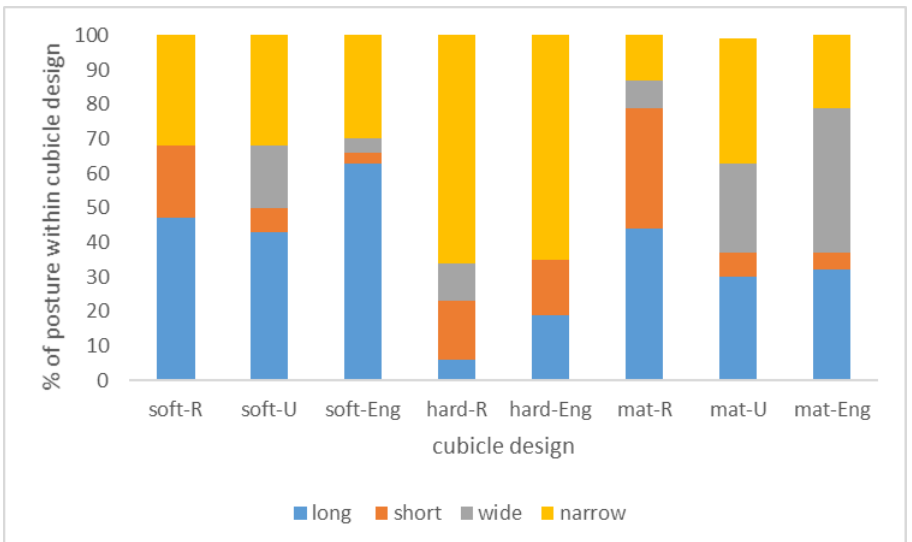
Figure 8. Recorded postures of cows in cubicles with different cubicle designs. Coded combinations of bedding materials and divider types are: soft = soft bedding, hard = hard floor, mat = mats or mattresses; -R = R-shaped dividers; -U = U-shaped dividers; and -Eng = English dividers. Results from 527 lying cows on 25 Dutch farms.